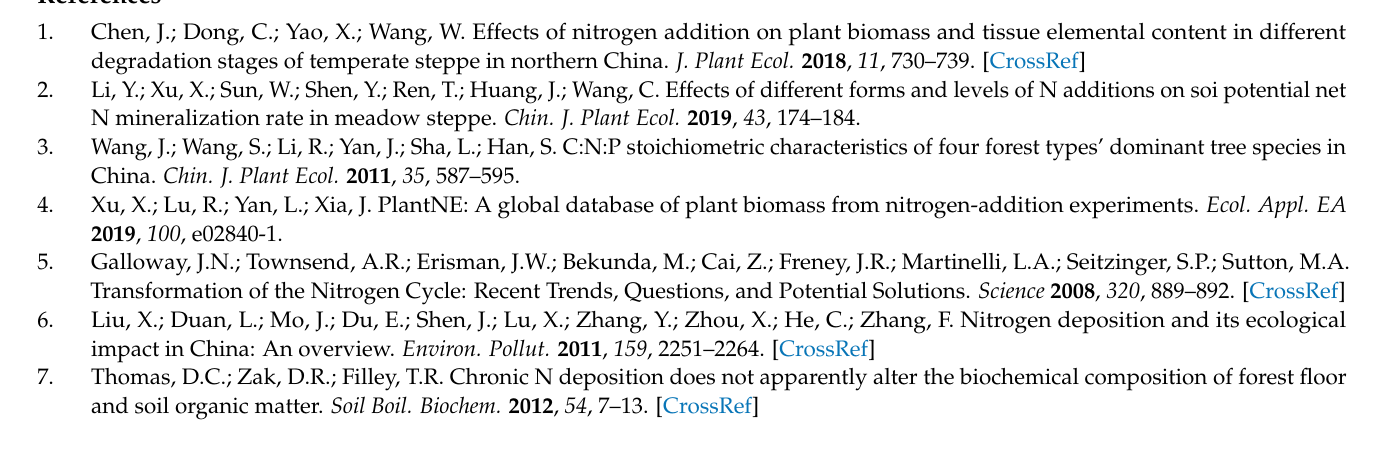
additions. Table S3: Dataset 2: N addition with other treatments. Table S4: Introduction—Table S1. Table S5: Abbreviation. Figure S1: N addition effects on biomass of N-fixing species in response to N